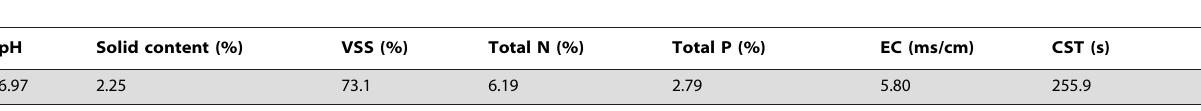
Table 1. Selected physicochemical characteristics of